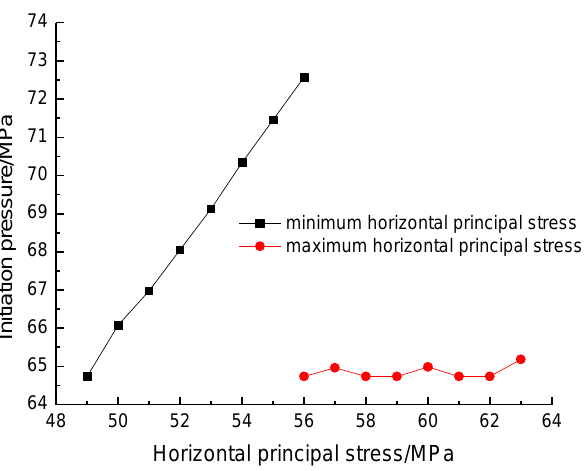
( d ) Figure 6. The contact-bond fracture and micro-fracture generation for the different injection pres- sure. ( a ) P 0 = 30 MPa. ( b ) P 0 = 40 MPa. ( c ) P 0 = 50 MPa. ( d ) P 0 = 60 MPa. 4.3.2. Fluctuation Analysis of Initiation Pressure on Reservoir Fracturing